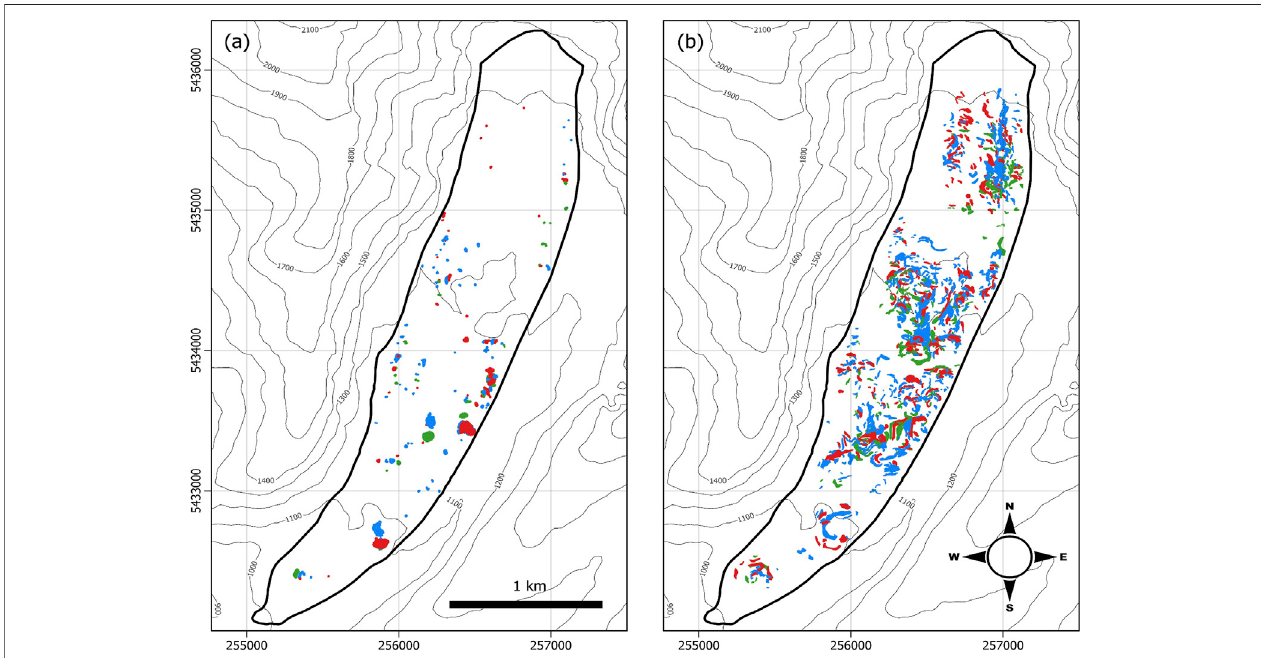
FIGURE3|(A) Ponds and (B) ice cliffsobserved overthe 2009 – 2019period onthedebris-coveredtongue ofVerdeglacier.Featuresare colour-codedinfunction of the period of the year they were mapped, blue corresponding to November 2009, December 2012 and November 2013; red to March 2012, March 2016, March 2018; and green to September 2015 and October 2019. Elevation data are based on SRTM DEM. Coordinates in meters, Universal Transverse Mercator (UTM) projection, zone 19, World Geodetic System (WGS84) datum.